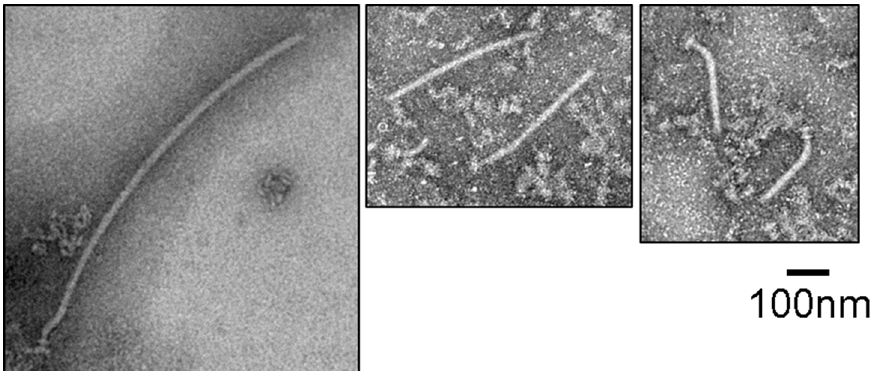
Figure 5. Autonomous hook–filament complex formation in the IMV. Negative-staining electron micrographs of the basal bodies after transport assay in the reaction mixture containing all the export proteins, their cognate chaperones, the export ATPase complex components, ATP, and Mg 2+ .